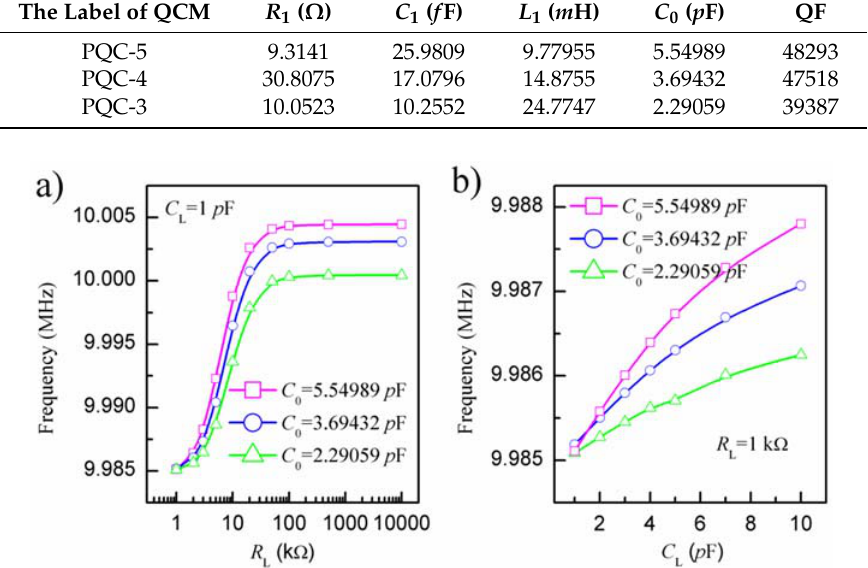
Figure 4. Simulation result of the resonance frequency of IDE-PQC sensor as a function of ( a ) R L or ( b ) C L .